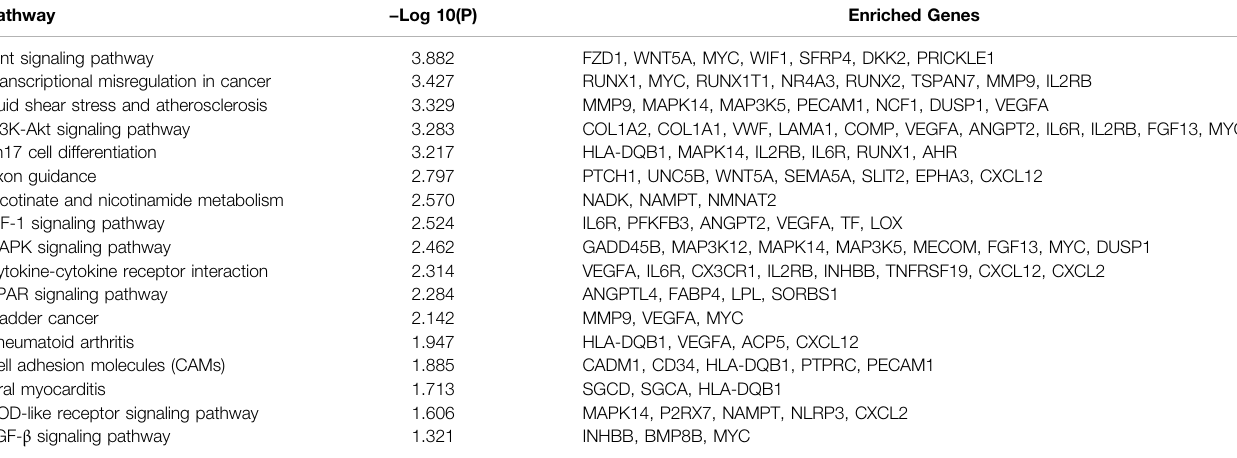
TABLE 3 | Enriched pathways and corresponding genes. Pathway − Log 10(P) Enriched Genes Wnt signaling